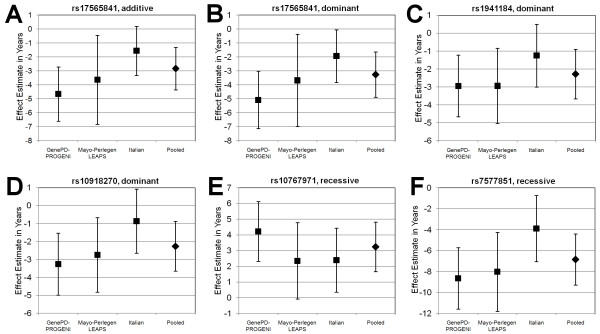
Forest plots showing study-specific and pooled effects for top six results in final meta-analysis. The effect (in years) on age at PD onset and 95% confidence intervals for the indicated genetic model are shown for each of the three independent samples and the combined analysis. A. Additive model of the A allele in SNP rs17565841 B. Dominant model of the A allele in SNP rs17565841 C. Dominant model of the C allele in SNP rs1941184 D. Dominant model of the A allele in SNP rs10918270 E. Recessive model of the T allele in SNP rs10767971 F. Recessive model of the T allele in SNP rs7577851.